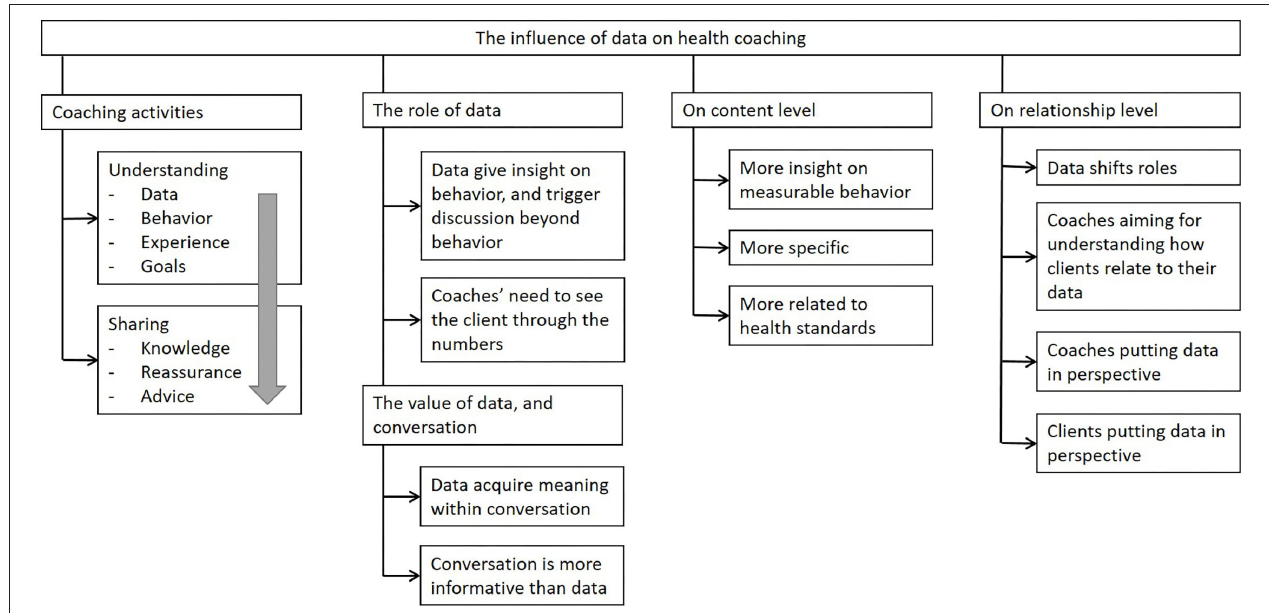
FIGURE 2 | An overview of results in four main categories: (1) incremental coaching activities and (2) the role and value of data therein, (3) how data affect health coaching on the content level and (4) on the relationship